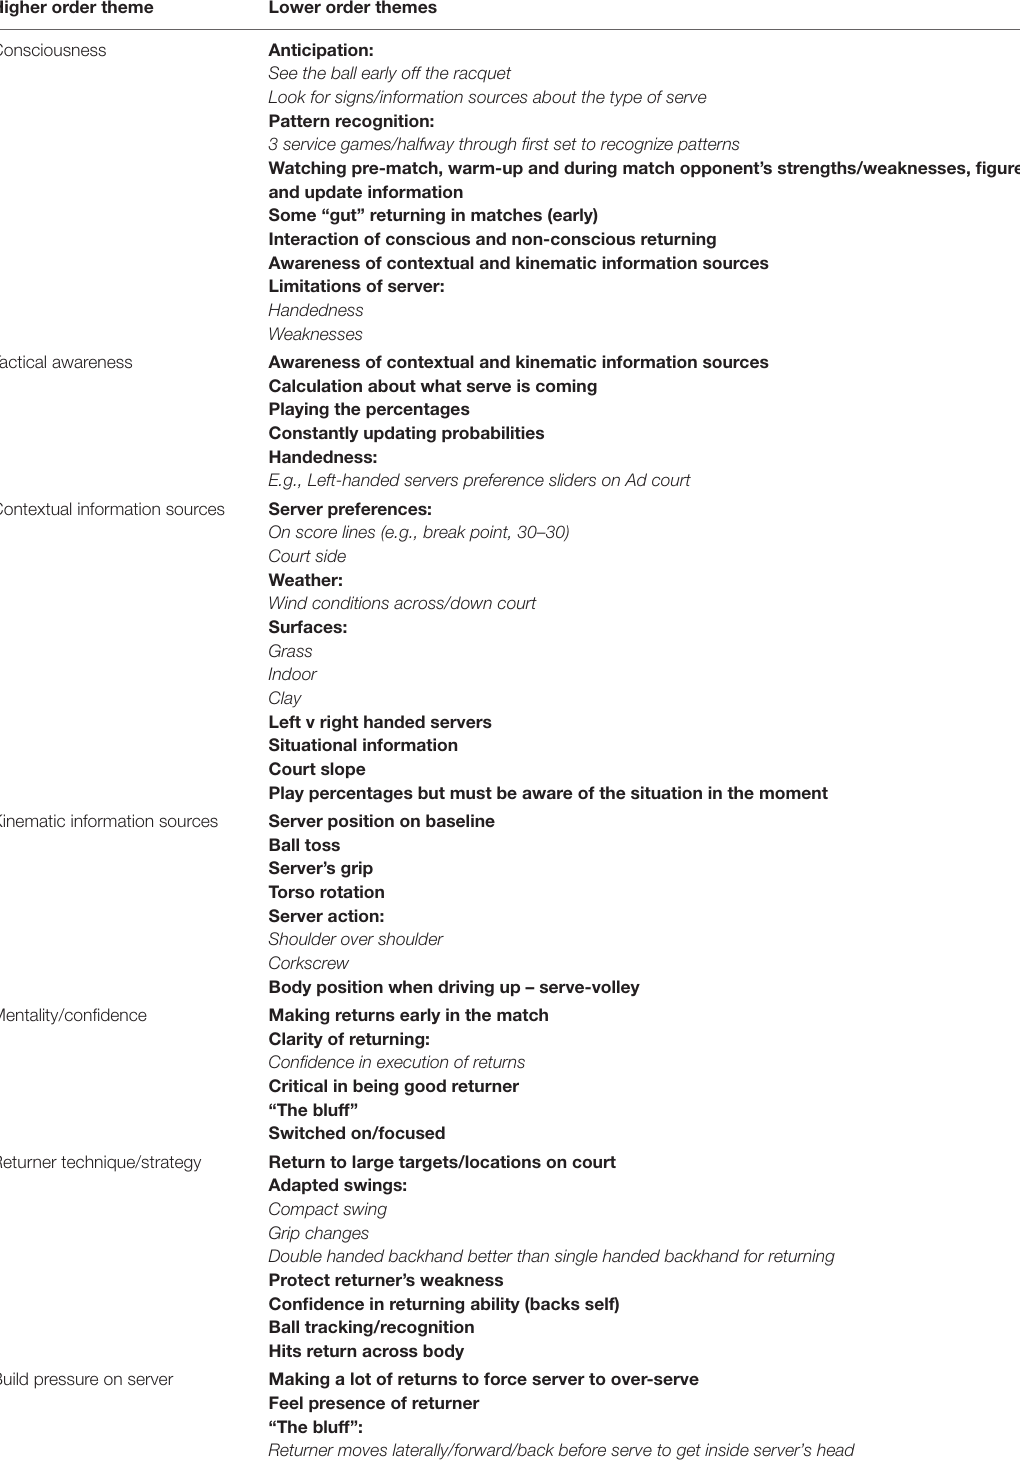
TABLE 2 | Nine higher order themes and the corresponding lower order themes resulting from return of serve anticipation interviews. Higher order theme Lower order